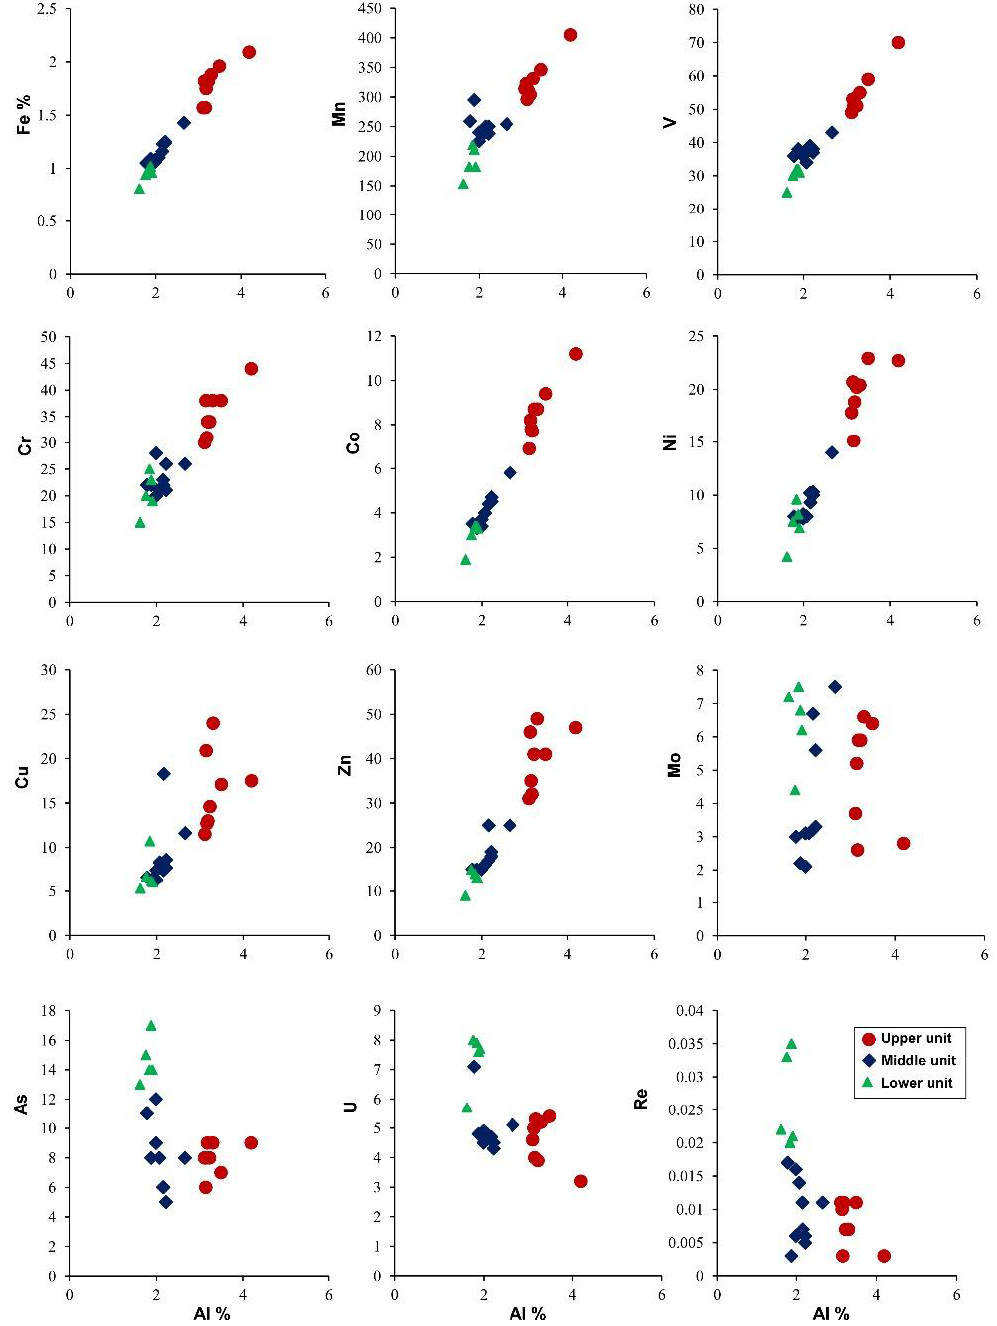
Figure 5. Bivariate plots between Al (%) and major (Fe %), minor (Mn) and trace elements V, Cr, Co, Ni, Cu, Zn, Mo, As, U, and Re (µg/g). Note the positive correlation with the first eight elements and the poor and negative correlation with the last four elements.